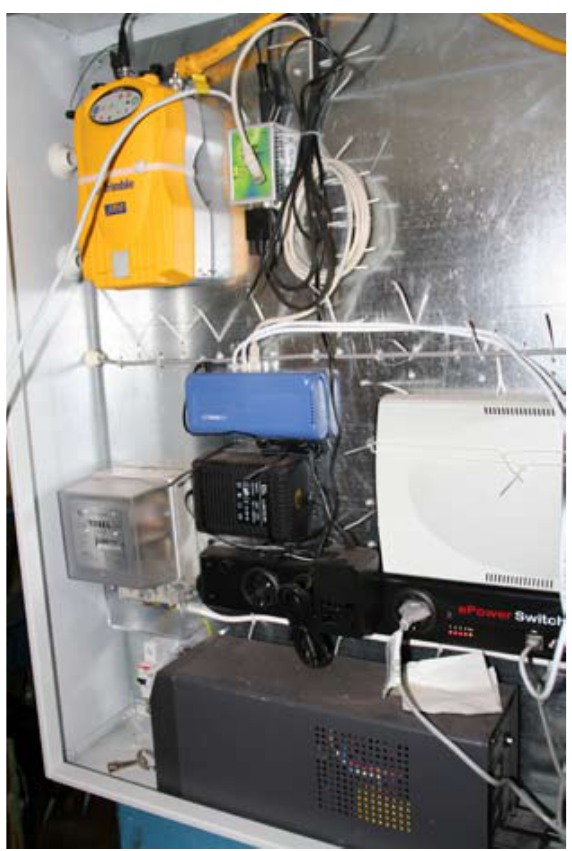
Fig. 3 . LitPOS station with Trimble 5700